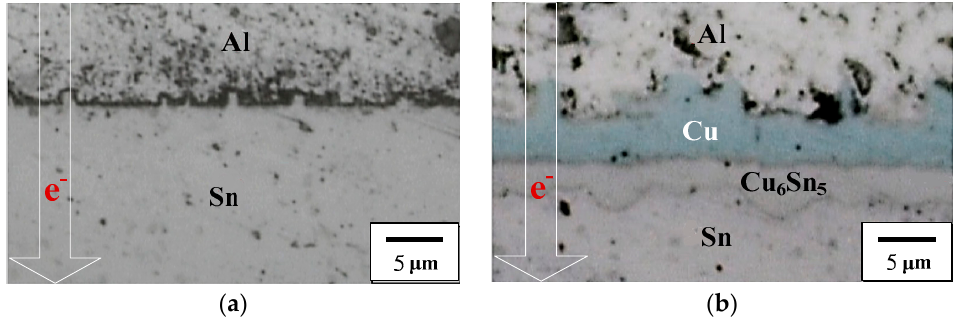
Figure 7. Interfacial microstructures of the HD PV module after Al-direction biasing for ( a ) 24 h and ( b ) 48 h.